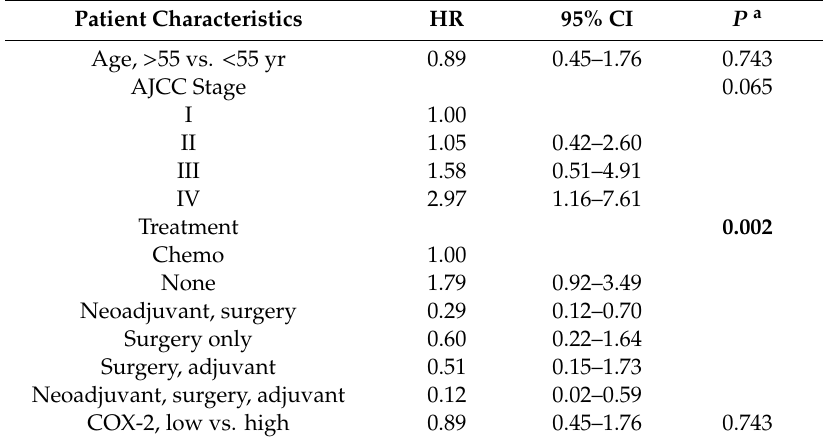
Table 7. Clinicopathologic factors predicating the prognosis in multivariate Cox regression